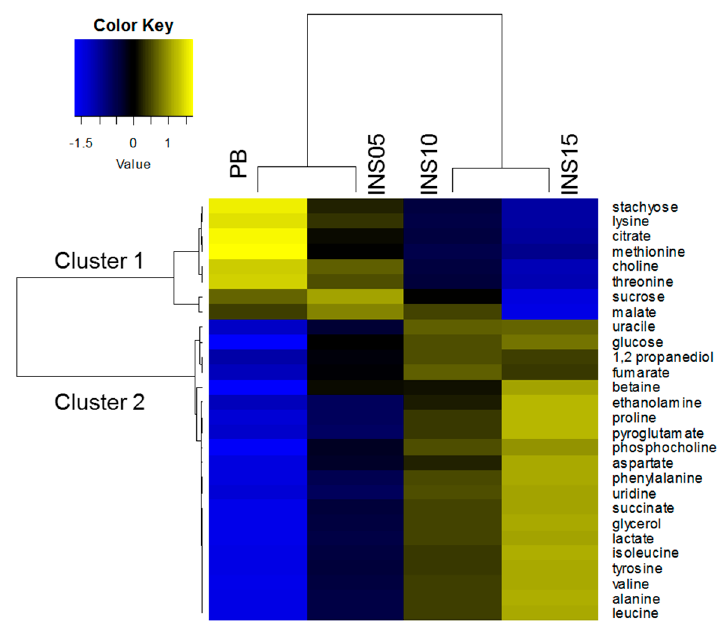
Figure 1. Hierarchical clustering analysis (HCA) heatmap of mean relative intensities of 28 compounds quantified using 1 H-NMR profiling in feed for control diet (PB) and three diets with increased amounts of insect ingredient (INS05, INS10, INS15).